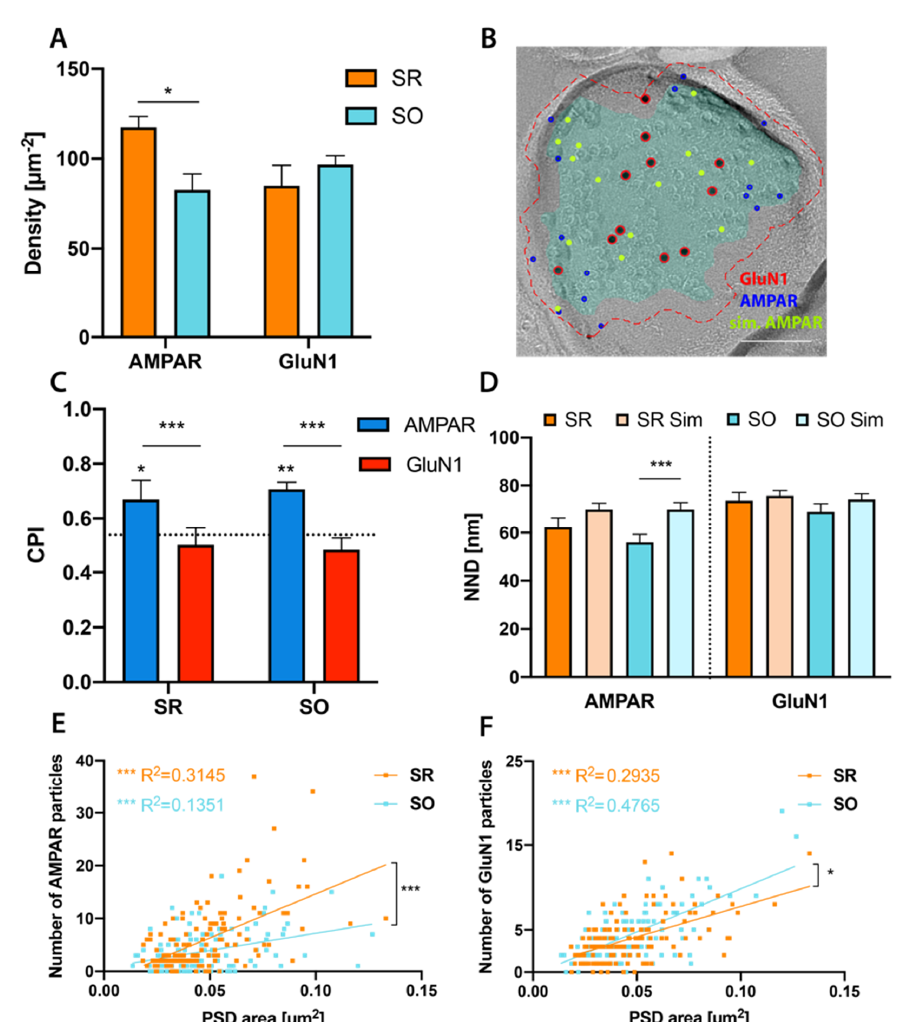
Figure 2. Glutamate receptor distribution in stratum radiatum (SR) and stratum oriens (SO) PSD. ( A ): Labeling density of GluA1-3 AMPAR (6 nm) and GluN1 (12 nm). AMPAR labeling is significantly denser in SR than SO (SR: 118 µm −2 , SO: 83 µm −2 , p = 0.018) while GluN1 labeling density is similar in both strata (SR: 85 µm −2 , SO: 97 µm −2 , p = 0.49) ( n = 4 mice, paired t -test with Holm–Sidak multiple comparison correction). ( B ): Example image showing Monte-Carlo simulation of randomly distributed AMPAR particles. Red, blue and green circles indicate real GluN1, real AMPAR and simulated AMPAR particles, respectively. Cyan overlay indicates the demarcation of PSD, red dashed line indicates outer rim 30 nm from the demarcation. Scale bar: 100 nm. ( C ): Center-Periphery index (CPI) of AMPAR and GluN1 particles in SR and SO. Dotted line at 0.536 indicates CPI of randomly distributed particles. In the example image shown in ( B ), the CPI for AMPAR and GluN1 particles is 0.95 and 0.42, respectively. GluN1 particles are distributed similar to random distribution in both strata (SR: p = 0.97, SO: p = 0.75). AMPAR particles in SR and SO are distributed significantly more peripheral than expected by chance (SR: p = 0.029, SO: p = 0.0059), as well as more peripheral than GluN1 particles (SR: p = 0.0007, SO: p = 0.0001) ( n = 4 mice, 3-way analysis of variance (ANOVA) with Sidak’s multiple comparison test; 225 partial and 30 complete PSDs were included in this analysis). ( D ): Comparison of real and simulated nearest-neighbour differences (NNDs) between AMPAR or